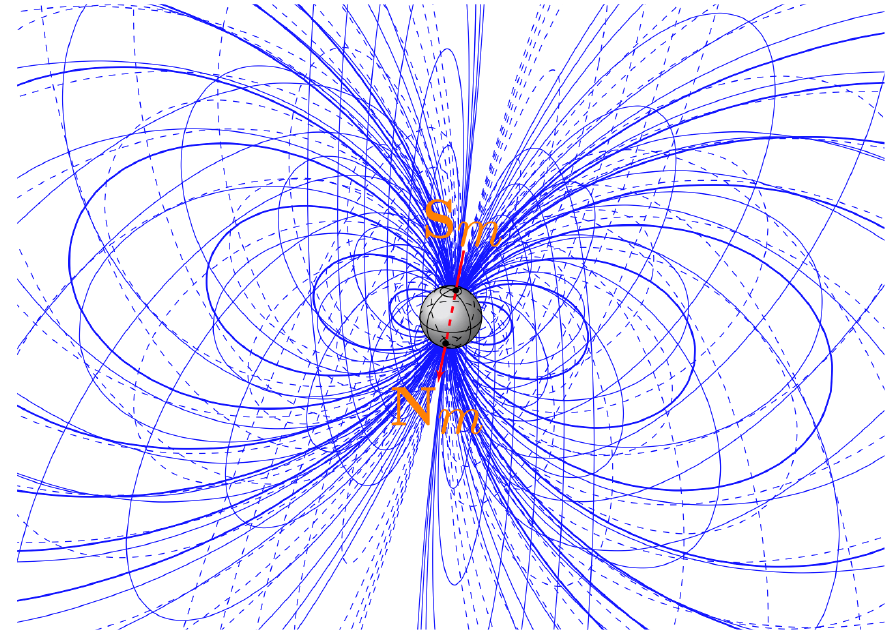
Figure 1. Geomagnetic field lines (blue) around the earth [22].